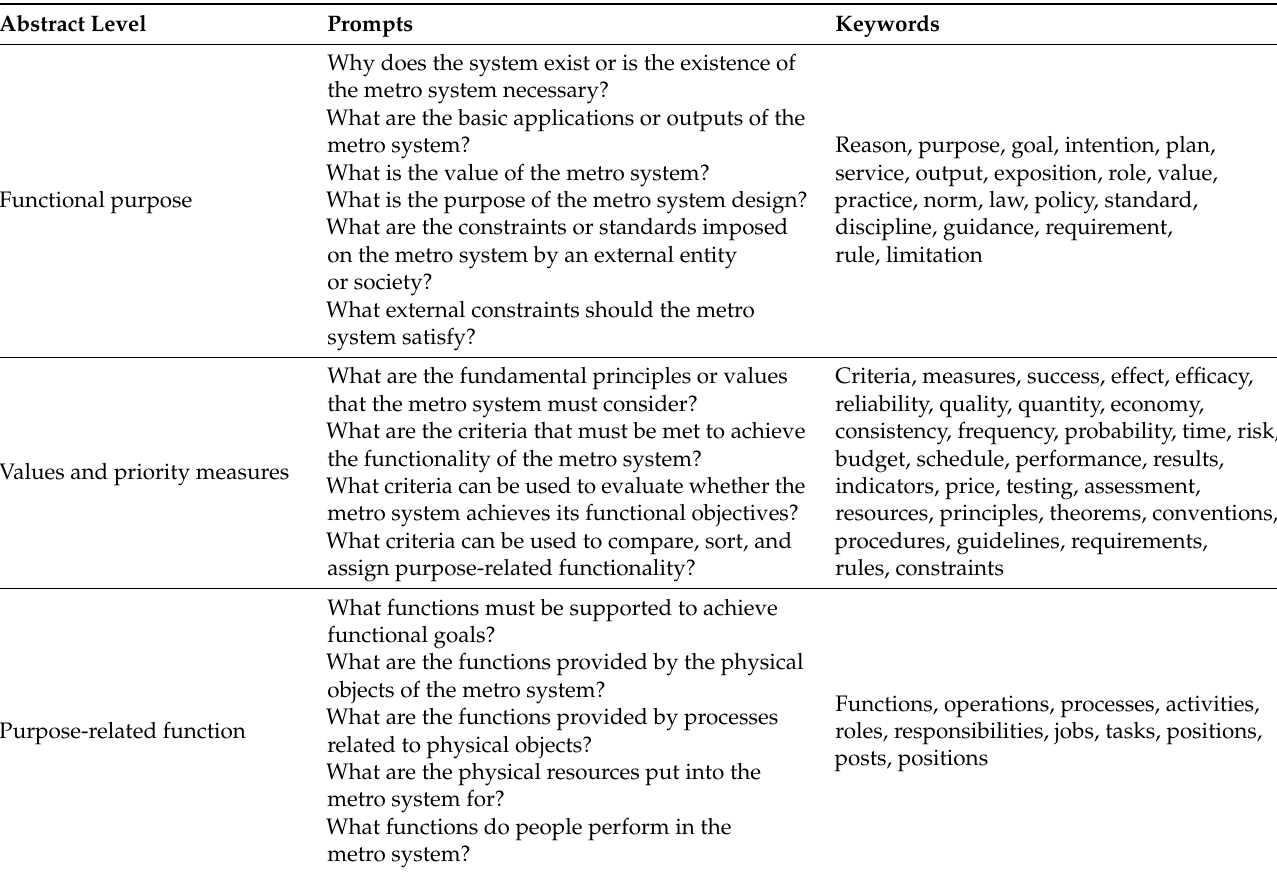
Table 1. Prompts and keywords related to abstract